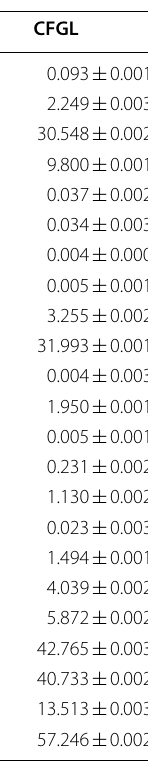
standard deviation. Data within a row, followed by the same letter are not significantly different at p < 0.05 ± Titus fish gills; CFHD =